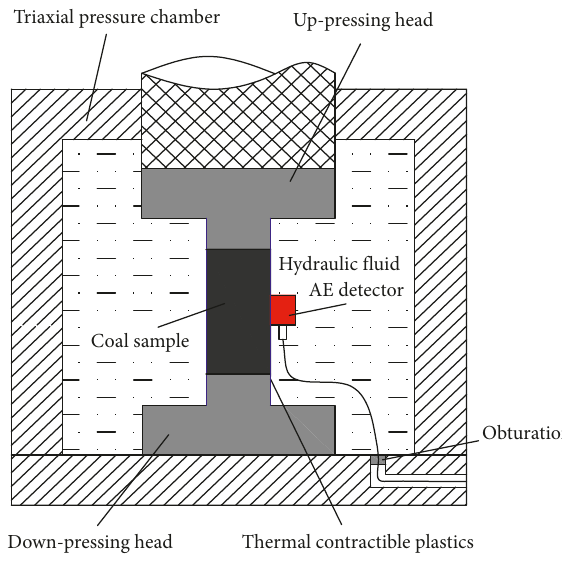
Figure 1: AE detector placed on the outer wall of the triaxial chamber.